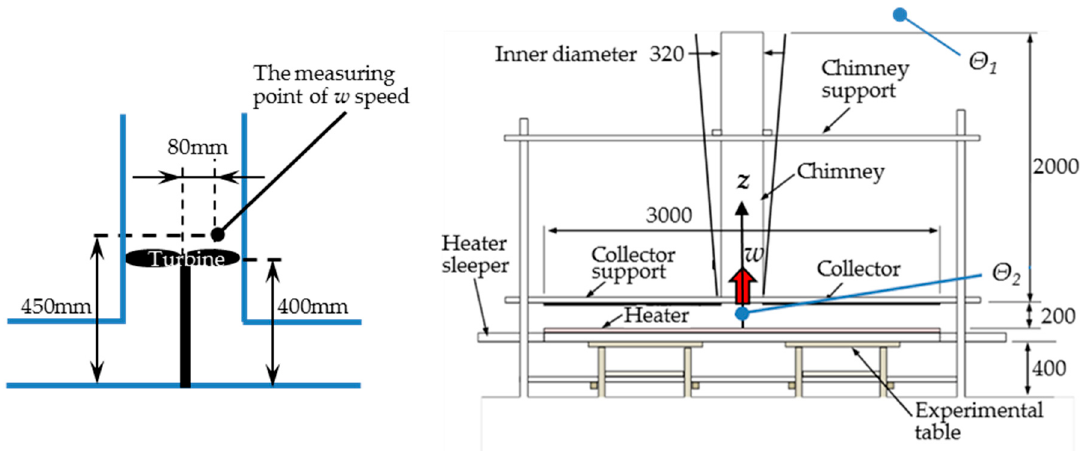
Figure 5. Experimental setup. Updraft wind speed w is measured by inserting an ultrasonic anemometer from the top into the tower. The dimension units in the right figure are all (mm).